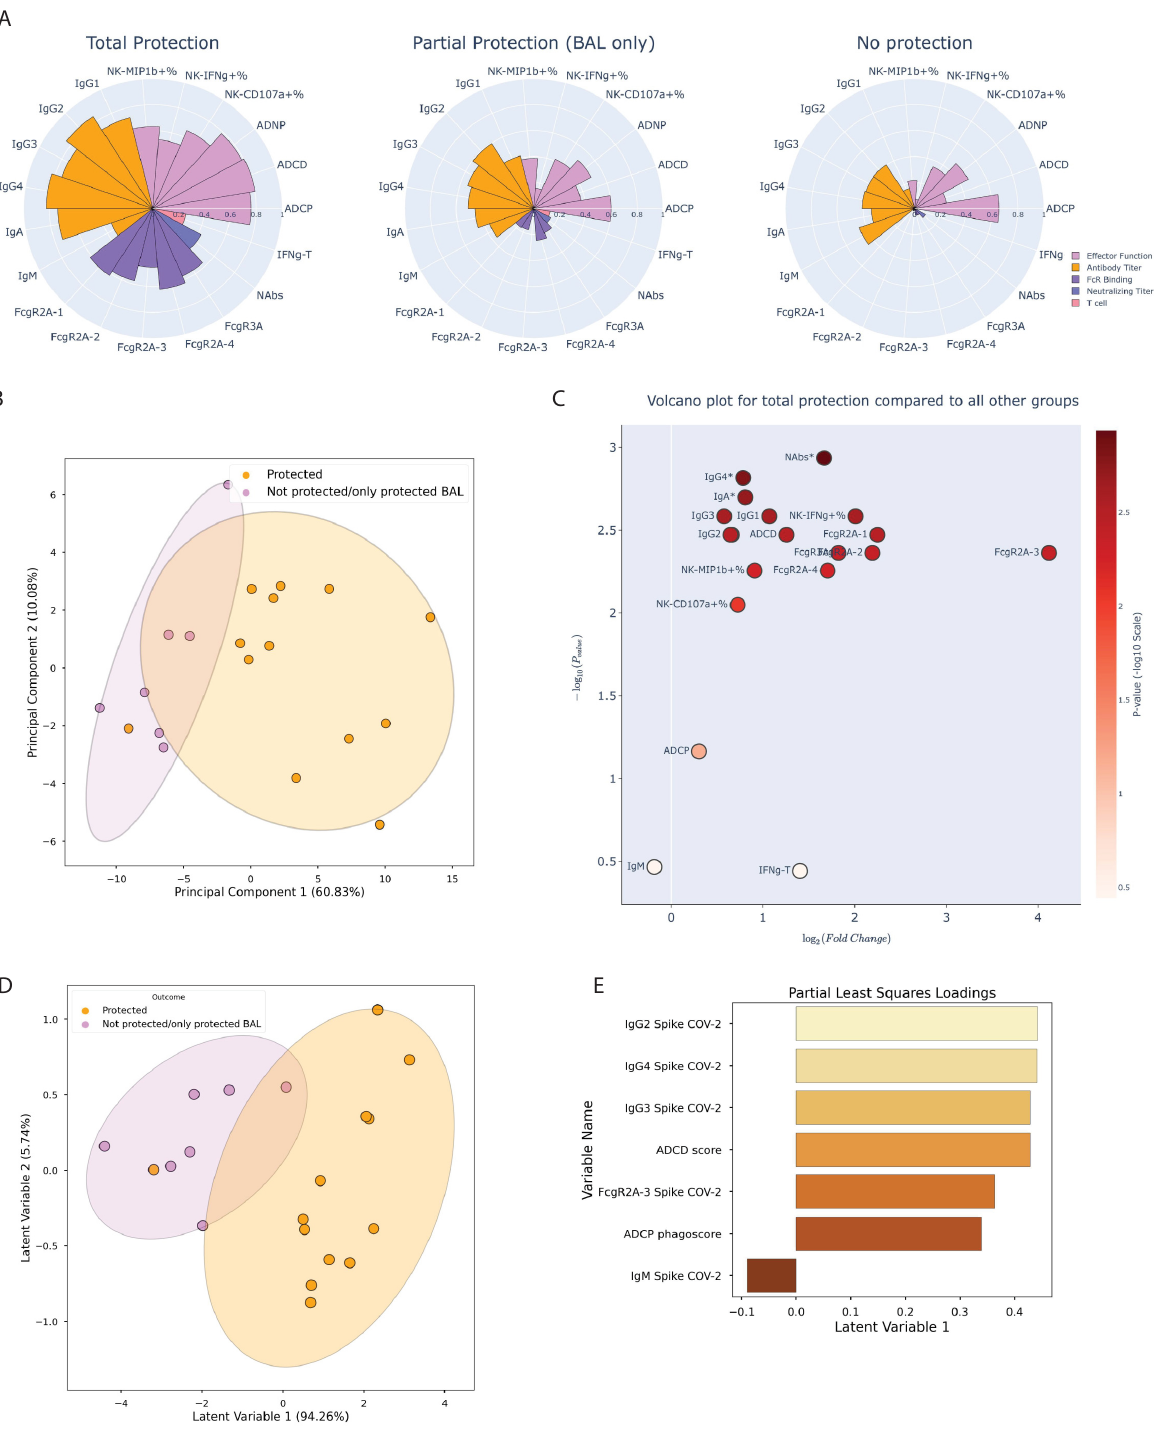
Fig 4. Multivariate analysis of the immune response for varying degrees of protection against SARS-CoV-2 challenge identifies key determinants of immunity. (A) Polar plots showing the mean percentile of each of the anti–SARS-CoV-2 antibody titers, FcR binding, and effector function activation features for NHPs, grouped by the degree of protection against viral challenge in the upper and lower respiratory tract; groups comprised NHPs protected in neither, one, or both compartments. Each wedge represents an individual feature, with colors representing the type of feature: orange: effector function; light purple: antibody titer; dark purple: FcR binding; blue: neutralizing antibody titer; and pink: T-cell IFN